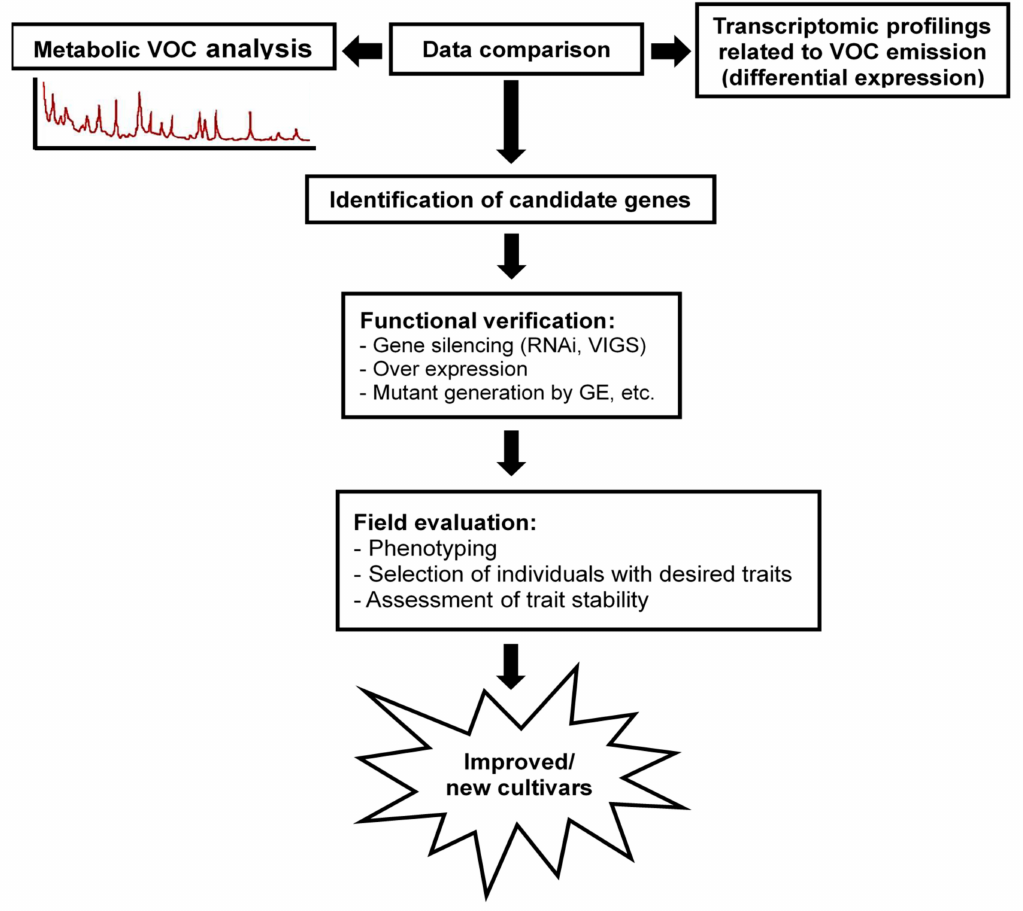
Figure 4. Schematic representation of functional studies for orchid breeding to develop floral scent